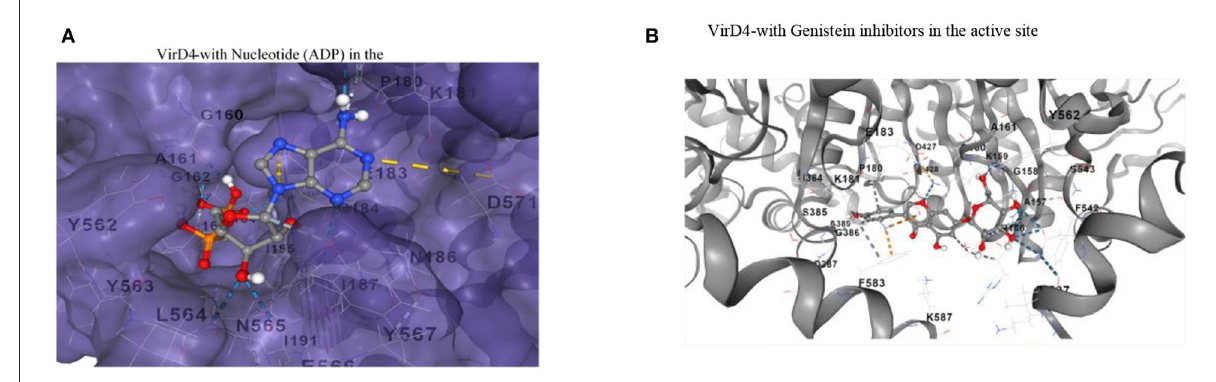
FIGURE4 (A) The substrate binding pocket in which the ADP molecule is docked in the active site and represented in the stick model. The interacting residues are shown and labeled in the active site cavity. The α -and β -phosphate groups of ADP are surrounded by P-loop binding residues. The adenine and ribose molecules are interacting with several charged residues. (B) Binding of genistein in the active site cavity of VirD4 structure on docking. The interacting residues are very similar for both ADP and genistein. Part of the molecule is surrounded by Walker A structure, a very similar phosphate group of ADP. Walker A and B motifs are mostly involved in interacting with genistein.